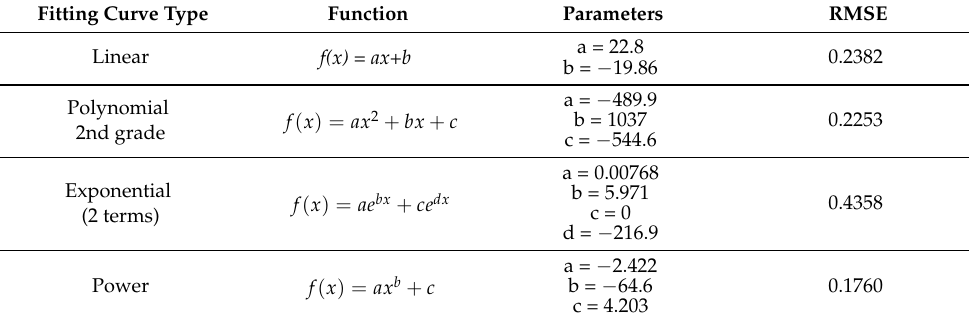
Table 9. Comparison between fitting curves for aCSF results.